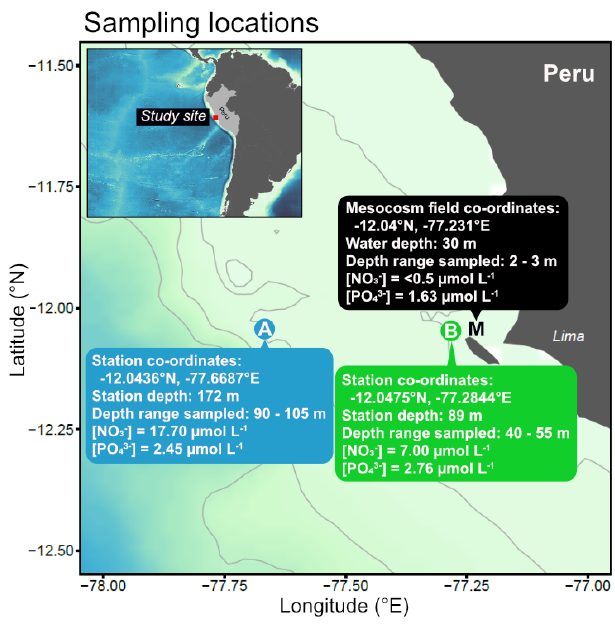
Figure 1. Map of sampling locations off the Peruvian coast indicat- ing collection sites and characteristics of water used in the incuba-